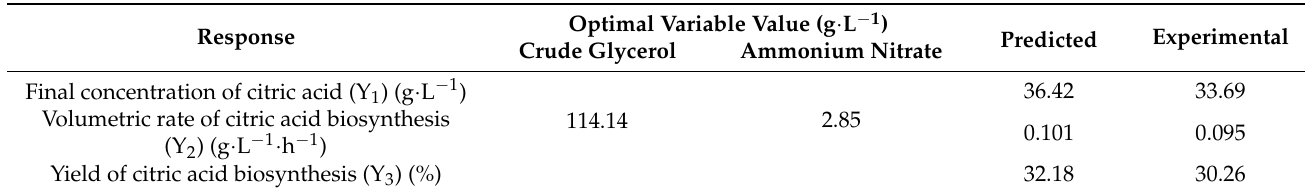
Table 1. Comparison of predicted and experimental response values of verification model.